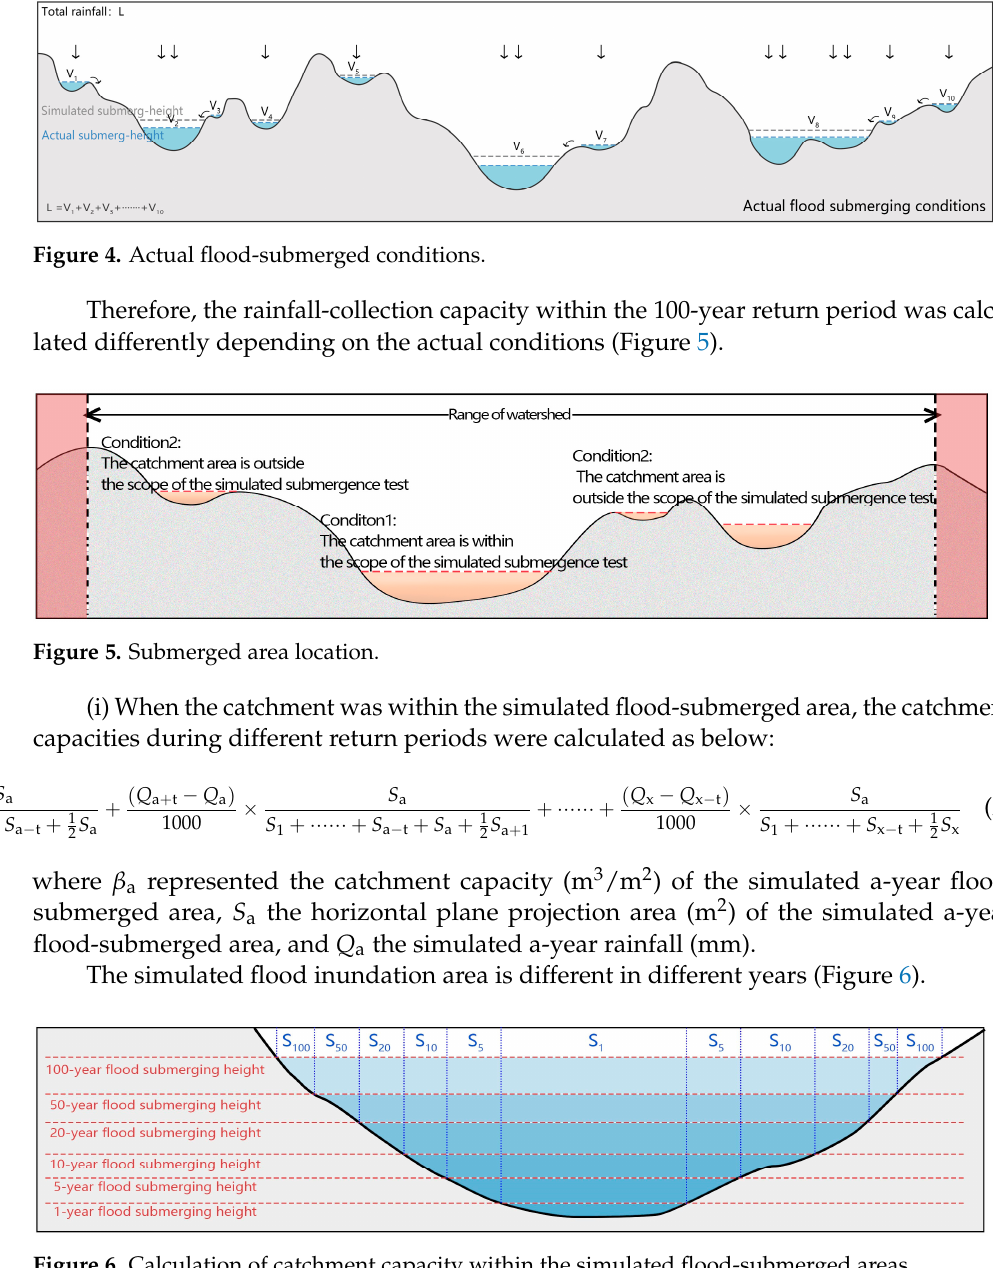
Figure 6. Calculation of catchment capacity within the simulated flood-submerged areas.